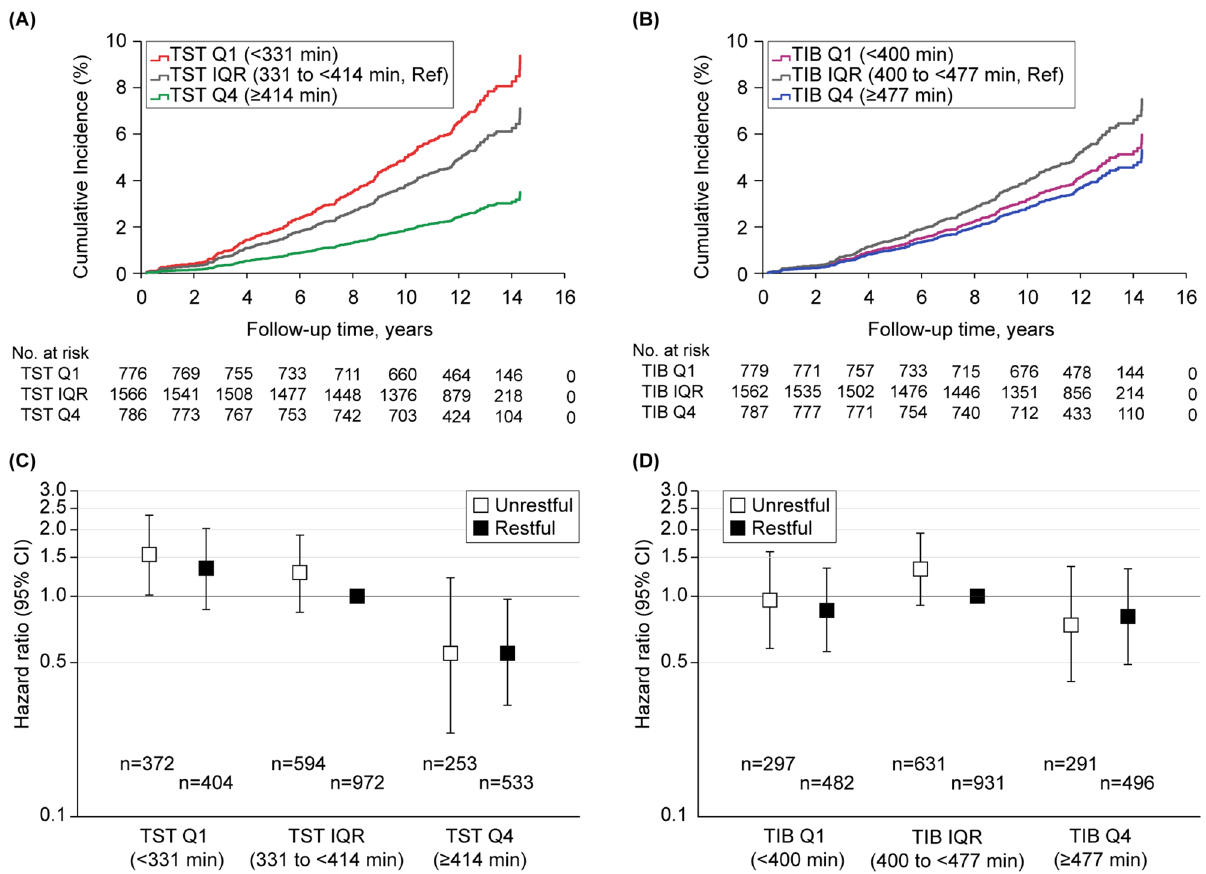
Figure 1. Adjusted Cox regression plots by total sleep time, time in bed, and sleep restfulness for middle- aged adults. Differential cumulative incidences or hazard ratios from the fully adjusted Cox proportional hazard models (Model 3) are shown for middle-aged adults: ( A ) cumulative incidences by TST quartiles; ( B ) cumulative incidences by TIB quartiles; ( C ) hazard ratios by TST quartiles with sleep restfulness; and ( D ) hazard ratios by TIB quartiles with sleep restfulness. CI confidence interval, IQR interquartile range, Q1 lowest quartile, Q4 highest quartile, Ref reference, TIB time in bed, TST total sleep